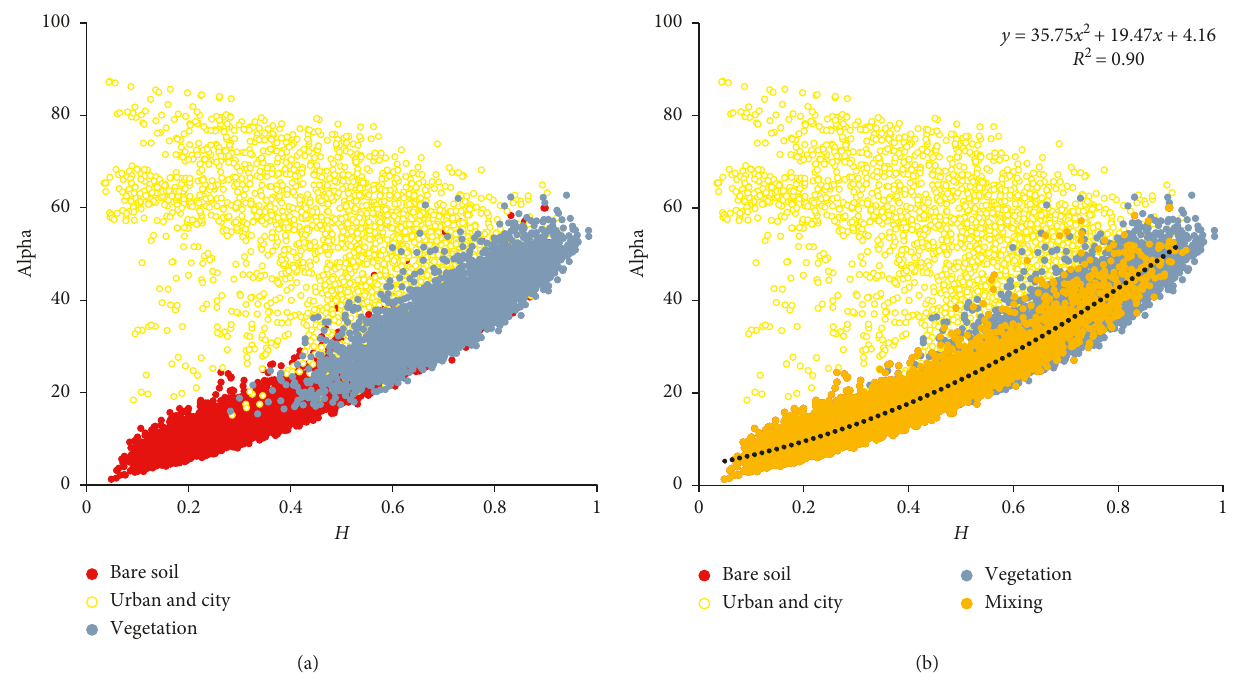
Figure 8: Two-dimensional feature space plots of H and Alpha (red points: bare soil field; yellow points: vegetated field; orange points: a field with mixed bare soil and